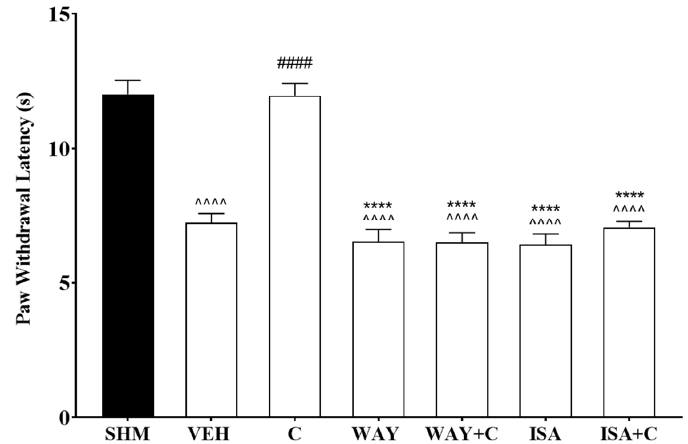
Figure 5. Effect of WAY 100,635 (5-HT1A receptor antagonist) and isamoltane (5-HT1B receptor antagonist) pre-treatment on cardamonin against thermal hyperalgesia of CCI-induced neuropathic pain mice were evaluated using Hargreaves’ Plantar test. Data were presented as mean ± SEM ( n = 6). The caret, hash, and asterisks denote the significance levels (one-way ANOVA, followed by Tukey’s post hoc test, ^^^^ p < 0.0001 as compared to sham, #### p < 0.0001 as compared to vehicle and **** p < 0.0001 as compared to cardamonin-treated group. SHM (Sham); VEH (Vehicle, 10 mL/kg i.p.); C (Cardamonin, 10 mg/kg i.p.); WAY (WAY 100635, 1.0 mg/kg, i.p.); ISA (Isamoltane, 2.5 mg/kg, i.p.).